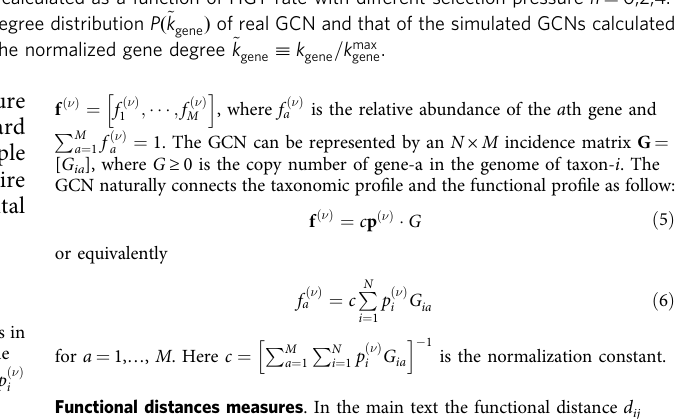
Fig. 4 A simple genome evolution model can generate GCNs that capture key topological features of the real GCN. a Schematic diagram of the genome evolution model. At each time step t , the genome of a species i (shown in red) randomly chosen with probability proportional to k h on one of the following three events: gene loss, gene gain, and horizontal gene transfer (HGT), with corresponding rates q gl , q gg , q HGT , respectively. Note that the parameter h ≥ 0 representing the selection pressure, and h = 0 corresponds to the case of neutral model. The three rates naturally satisfy q gl